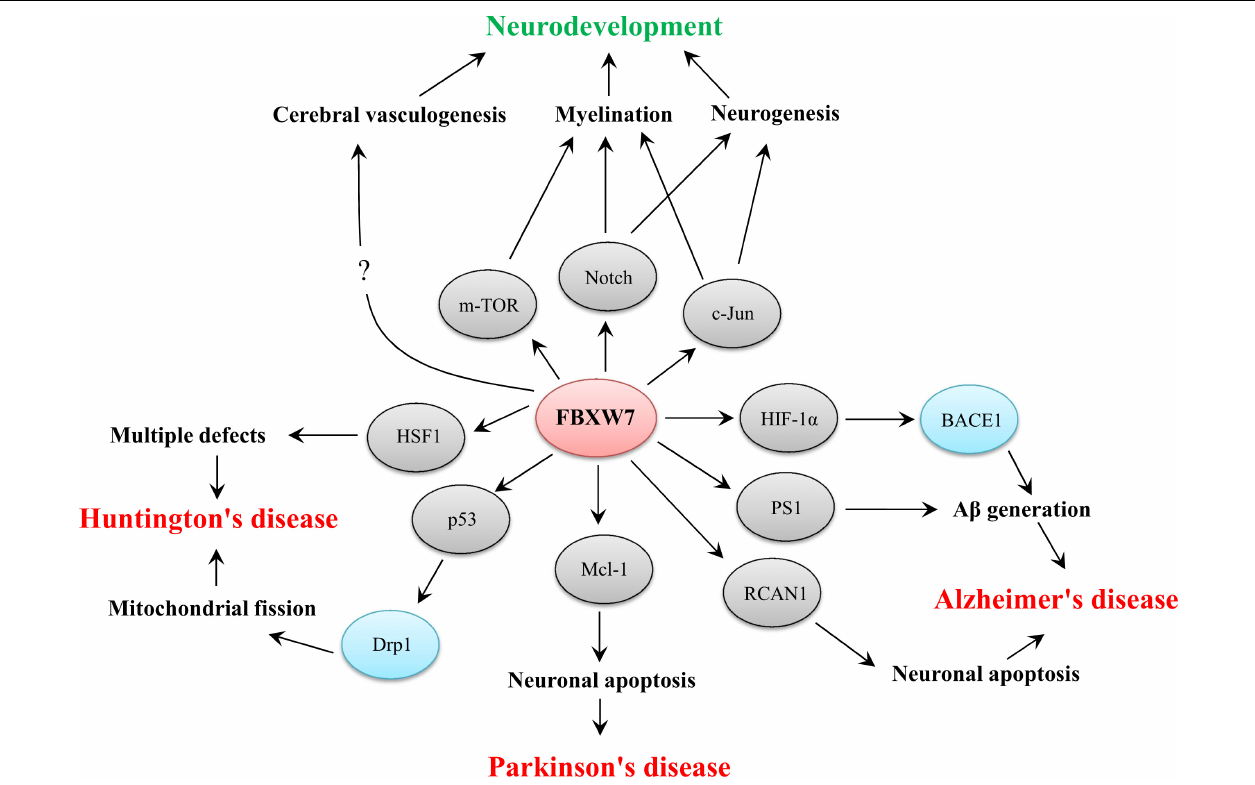
FIGURE 2 | Functional implications of FBXW7 in neurodevelopment and three typical neurodegenerative diseases. The substrates of FBXW7 and other downstream factors are presented by gray or blue ellipses,